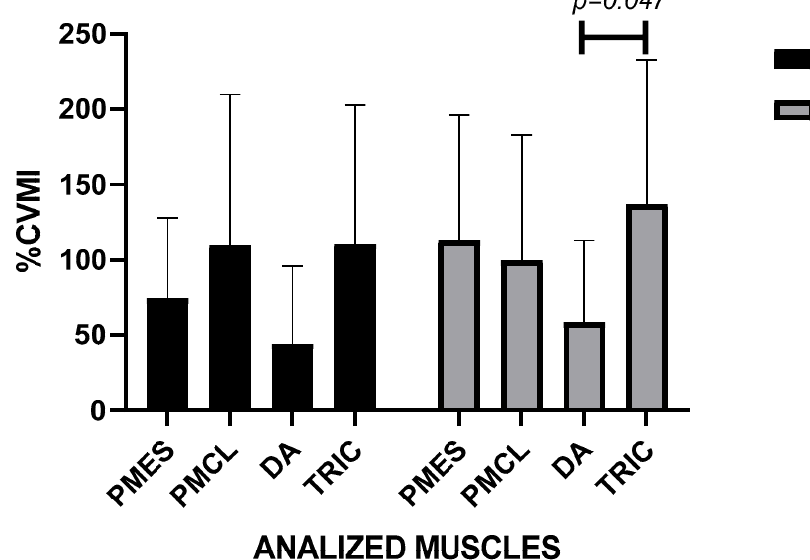
Figure 2. Muscle activation with a relative load of 100% 1RM in conditions untied and tied with leg/bench straps in paralympic powerlifting athletes. Legend: PMES = Pectoralis Major sternal portion; PMCL = Pectoralis Major clavicular portion; DA = Anterior deltoid; TRIC = triceps brachii; CI = − 155.9 to 0.675.